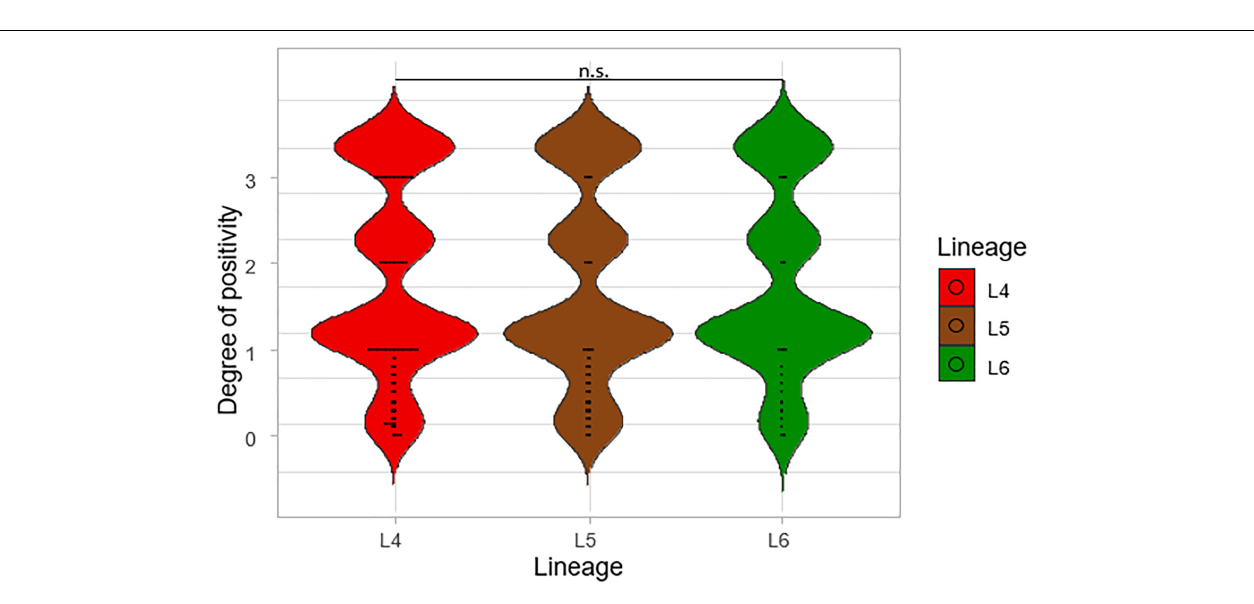
FIGURE 4 | A large-scale comparison of the smear microscopy results of the lineages. The degrees of positivity of the lineages were compared using a total number of 2,043 isolates from a previous study (L4 = 1,563, L5 = 289, and L6 =